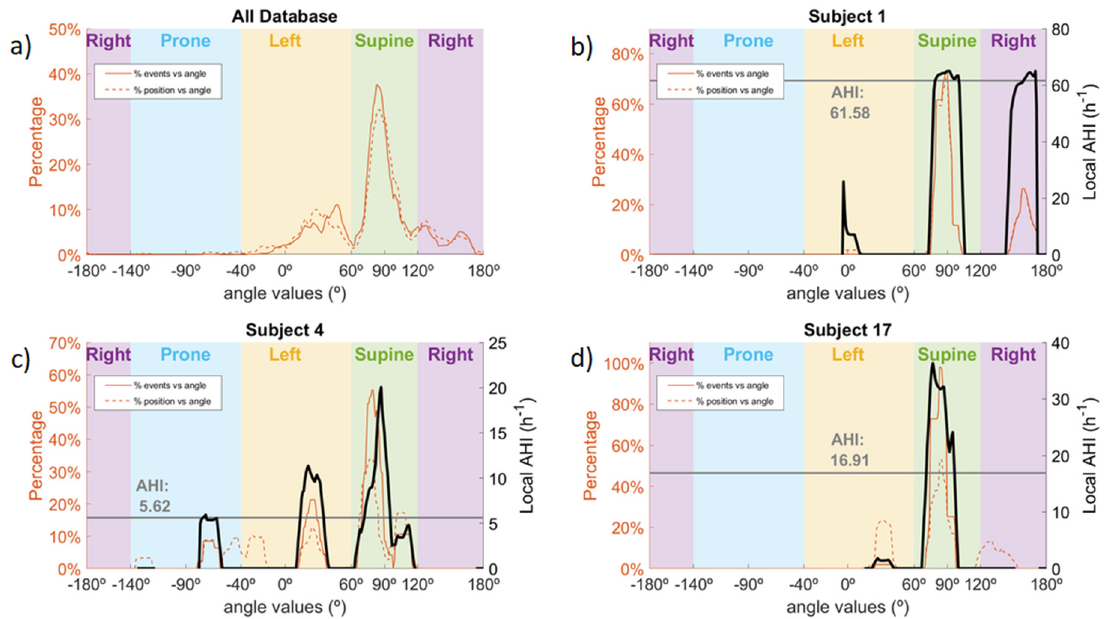
Figure 5. Percentage of OSA events and percentage of sleep position time in the database ( a ) with three individual examples ( b – d ). In ( a ), it is possible to observe the distribution of OSA events and sleep position time as a function of sleep angle for the whole database. The other three subfigures are examples of a clear non-pOSA patient ( b ), a clear pOSA patient ( d ) and an unclear pOSA patient ( c ), according to the local AHI displayed in black as a function of sleep angle. For each of the three subjects, the AHI of the whole night is shown with a grey line.